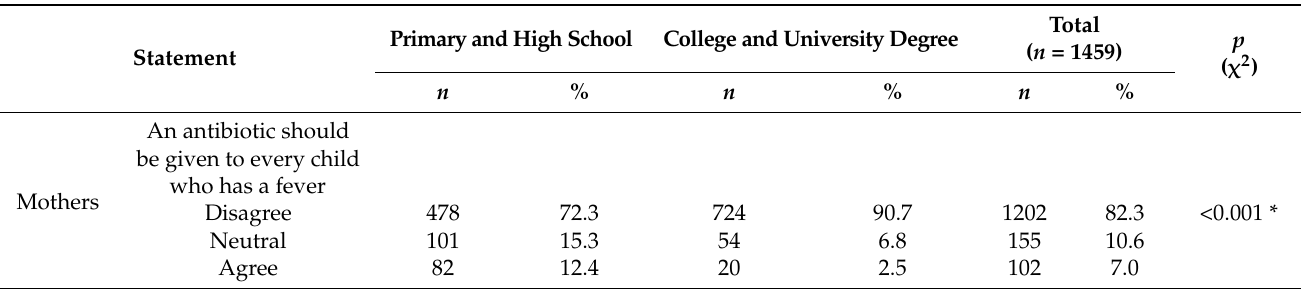
Table 6. Knowledge of parents about